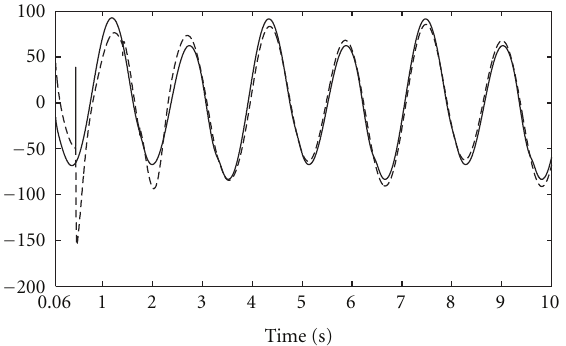
Figure 7: Control u ( t ) on the time interval [0.06, 10]. dashed line for the multiple model case ( N = 4) in [7], and solid line for the multiple model developed in this